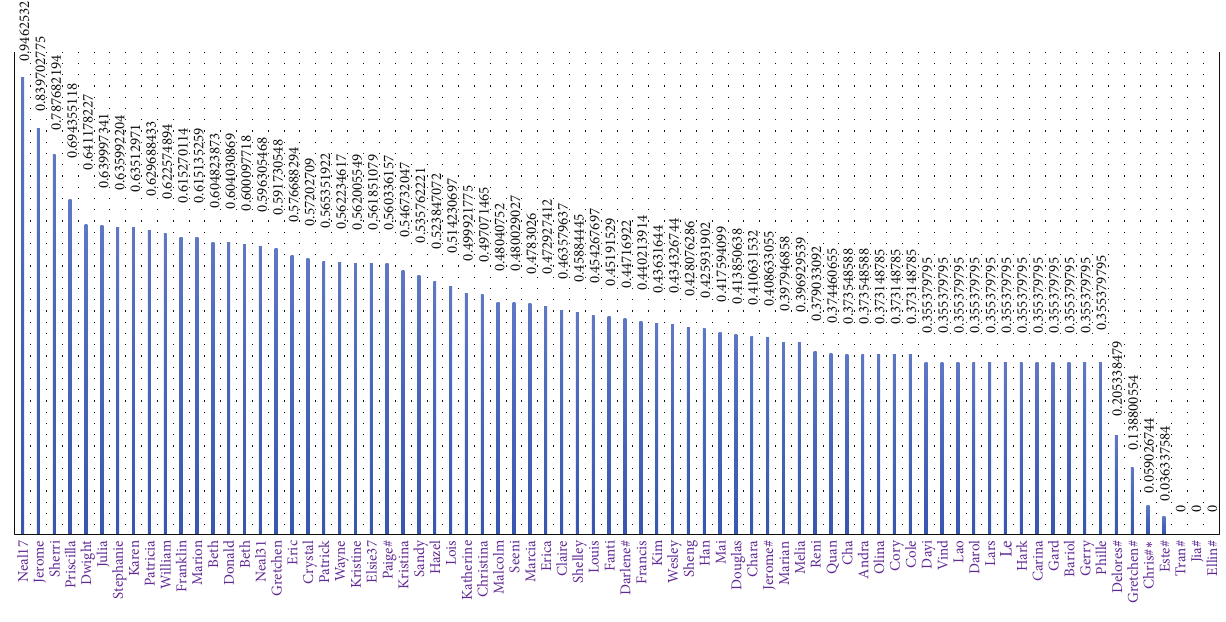
Figure 5: Suspect nomination priority list without new